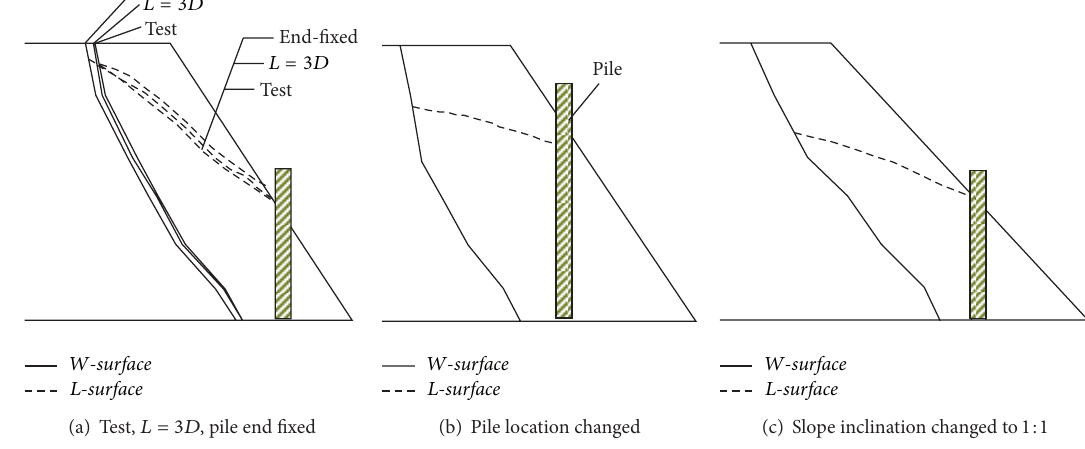
Figure 20: W-surfaces and L-surfaces considering different factors. L : pile spacing; D : pile